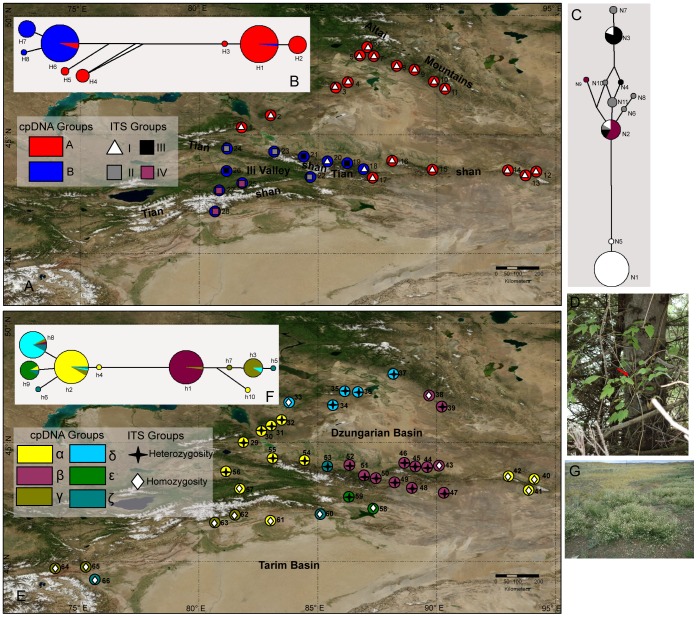
Sampling locations and distributions of population groups in Clematis sibirica (A) and C. songorica (E) in arid Eastern Central Asia.Population codes are consistent with the population names shown in Table S1. The color of each pie corresponds to the cpDNA population groups; the symbols with different colors correspond to the nrITS population groups. (B, F) Median-joining networks for recovered chlorotypes in these two species. The colors within each chlorotype are consistent with the cpDNA population groups. (C) Median-joining networks for recovered ribotypes in Clematis sibirica. The colors within each ribotype are consistent with the nrITS population groups. (D, G) Habitats of these two species.